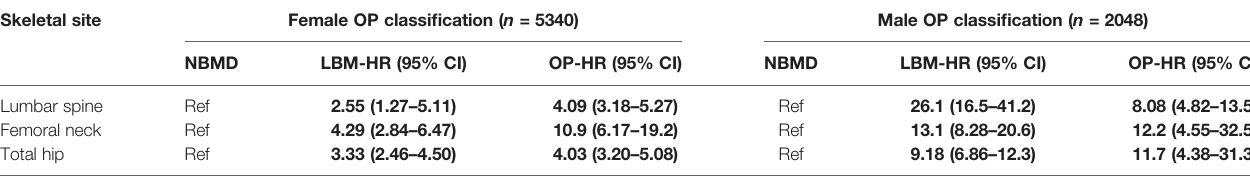
TABLE 4 | In fl uence of osteoporosis classi fi cation on fracture hazard ratio (HR). Skeletal